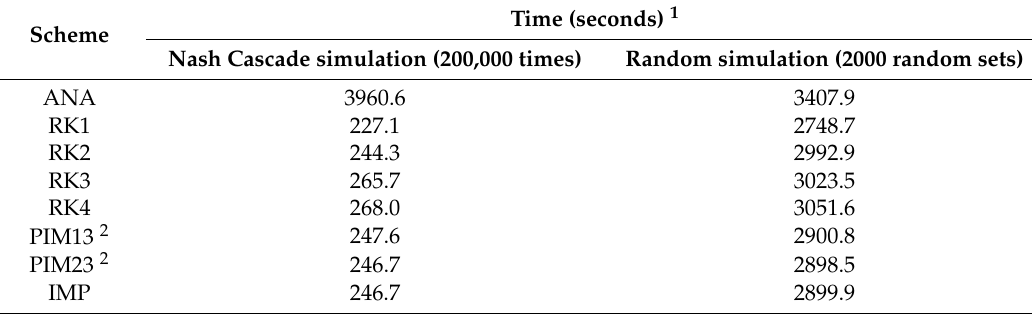
Table 4. Computational time in the random test for all the numerical schemes. Time (seconds) 1 Scheme Nash Cascade simulation (200,000 times) Random simulation (2000 random sets) ANA 3960.6 3407.9 227.1 2748.7 244.3 2992.9